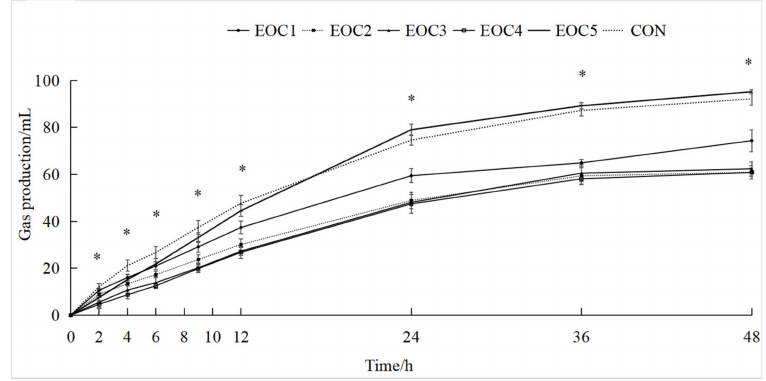
Figure 1. Variation of gas production at 0~48 h. * p <